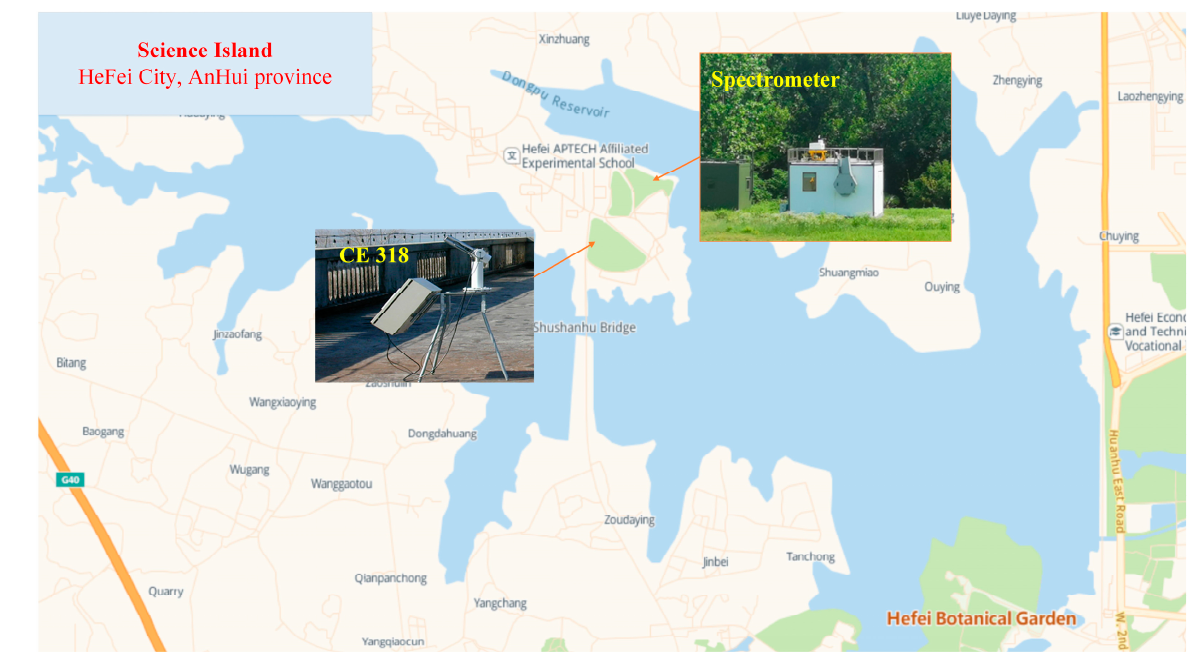
Figure 32. GMI data product foundation authenticity verification laboratory.